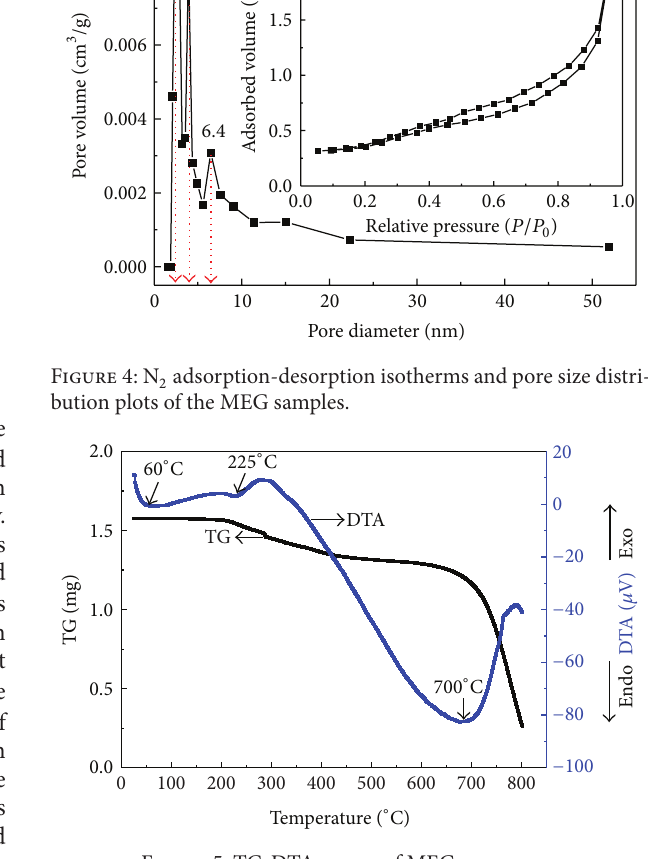
Figure 5: TG-DTA curves of MEG